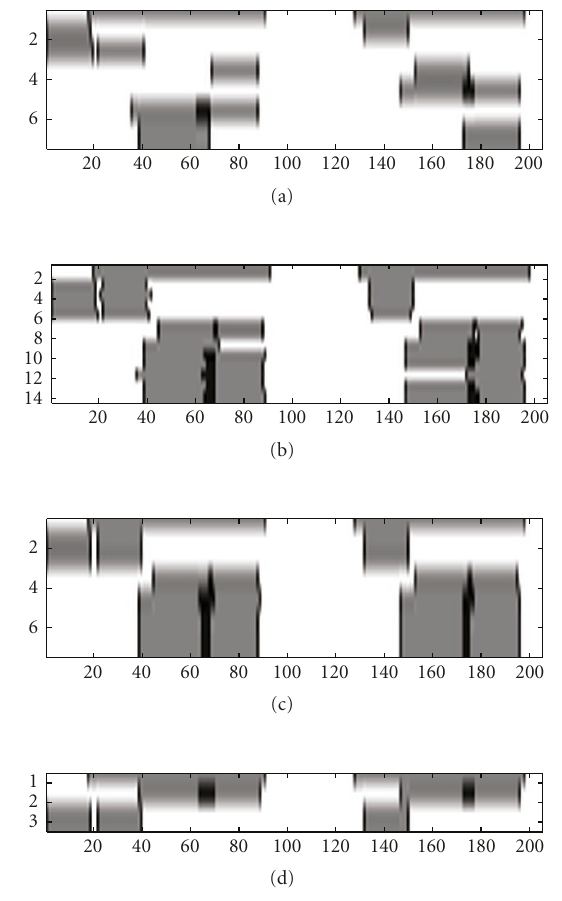
Figure 12: Steps of the clustering algorithm for the Brahms exam- ple, see Figure 9. For details we refer to Figure 11. The final result correctly represents the global structure: the cluster of the second row corresponds to { B 1 , B 2 , B 3 , B 4 } , and the one of the third row to A A { A } . Finally, the cluster of the first row expresses the simi- 1 , 2 , 3 larity between A 2 B 1 B 2 and A 3 B 3 B 4 (cf. Figure